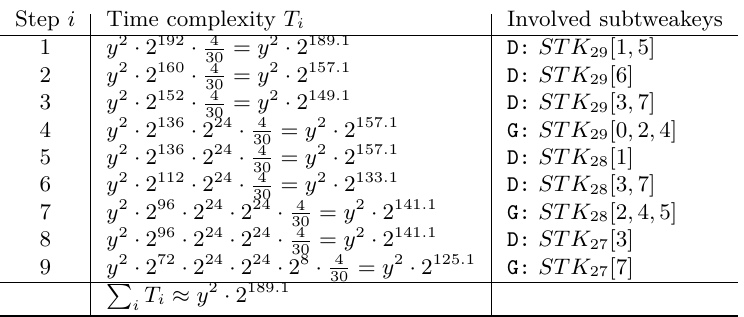
Table 10: Time complexity and guessed subtweakeys of each step in the tweakey recovery process for 30-round SKINNY-128-384 . D: deduced key cells; G: guessed key cells. Step i Time complexity T i Involved